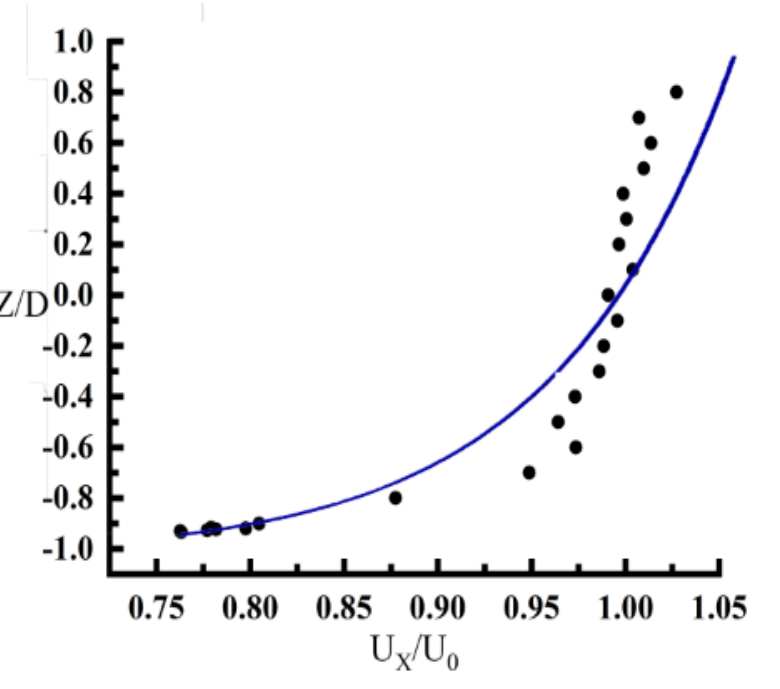
Figure 2. Vertical velocity distribution.